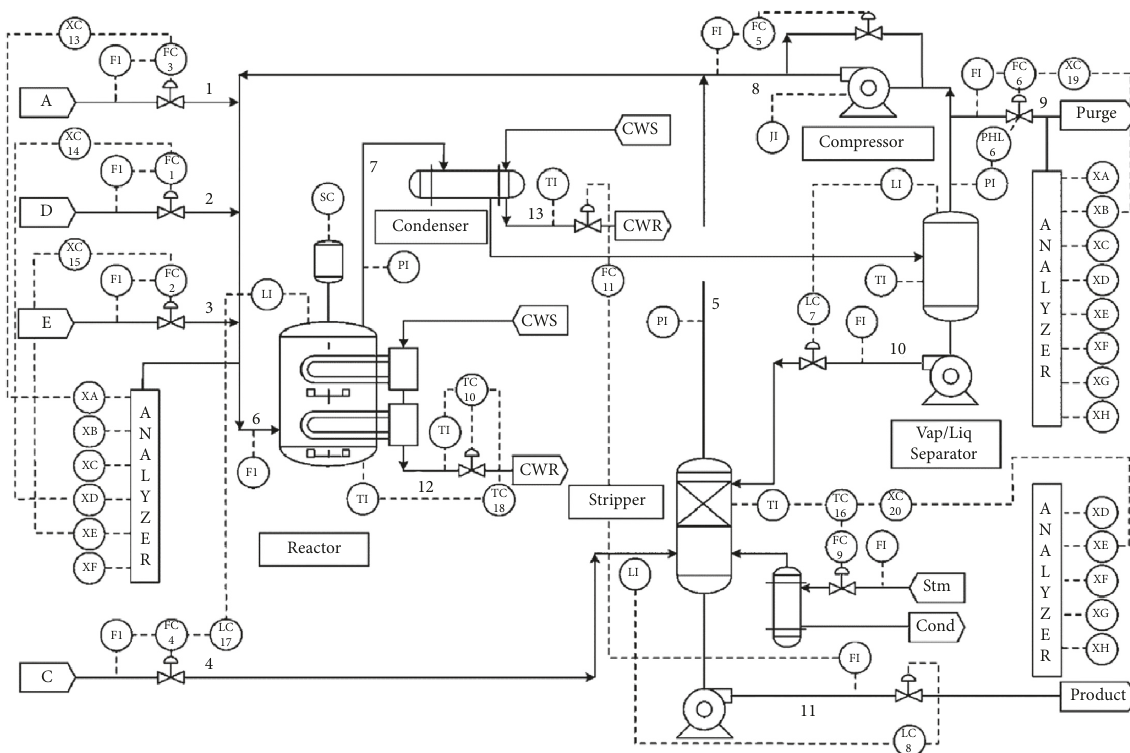
Figure 2: Control system of the TE